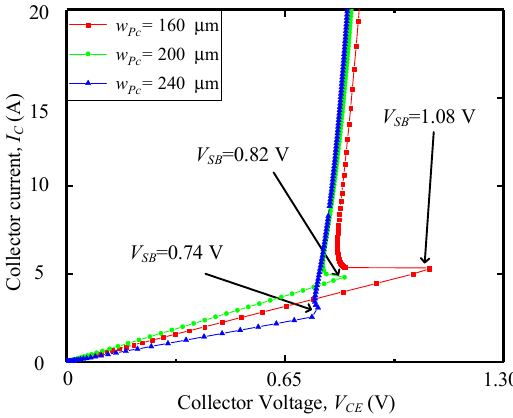
Figure 4. Impact of the P-collector width w Pc on snap-back.